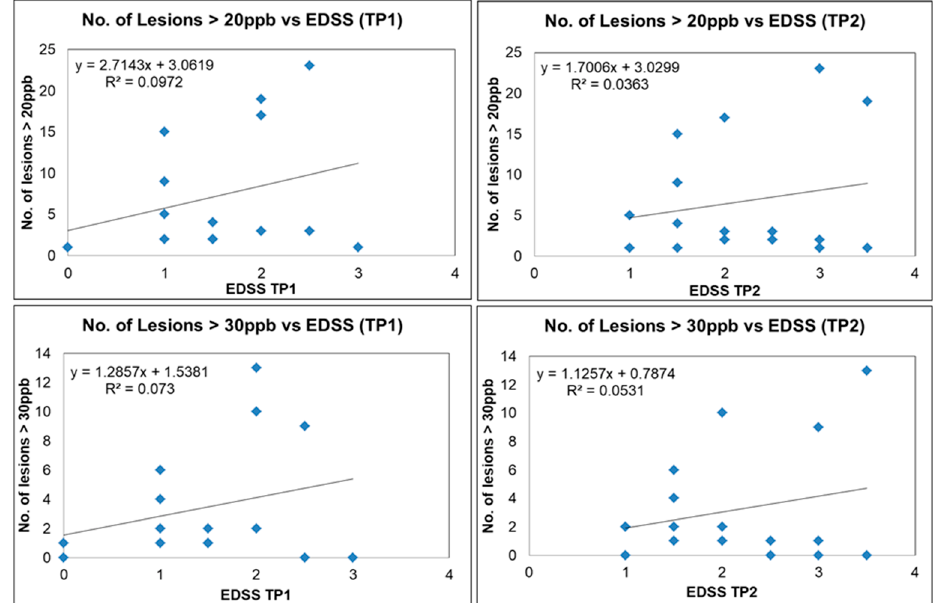
Figure 9. Number of lesions versus EDSS for QSM-positive lesions for different MS subjects (blue squares) with susceptibility of more than 20 ppb for time point 1 (upper left image) and time point 2 (upper right image). Number of lesions versus EDSS for QSM-positive lesions with susceptibility more than 30 ppb for time point 1 (lower left image) and time point 2 (lower right image).